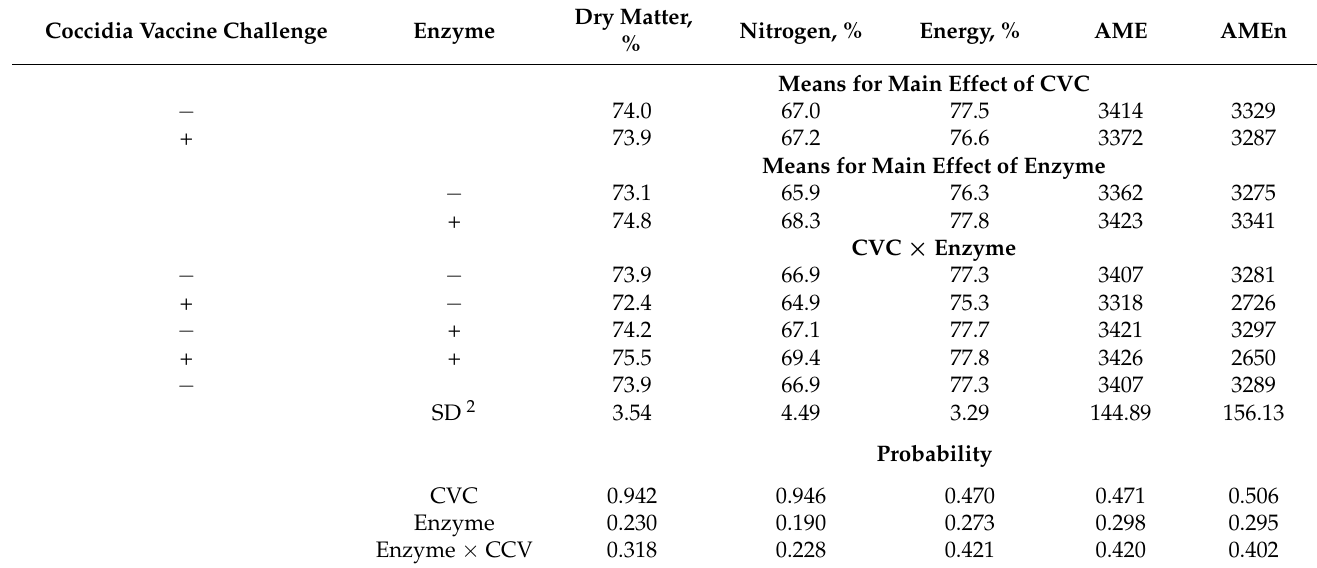
Table 6. Main and simple effects of coccidia vaccine challenge (CVC) and exogenous enzyme supplementation on nutrient and energy retention, apparent metabolizable energy (AME), and apparent metabolizable energy corrected for nitrogen (AMEn) in 28-day-old broiler chickens fed wheat-corn-soybean meal-based diets (14-day post-challenge) 1 . Coccidia Vaccine